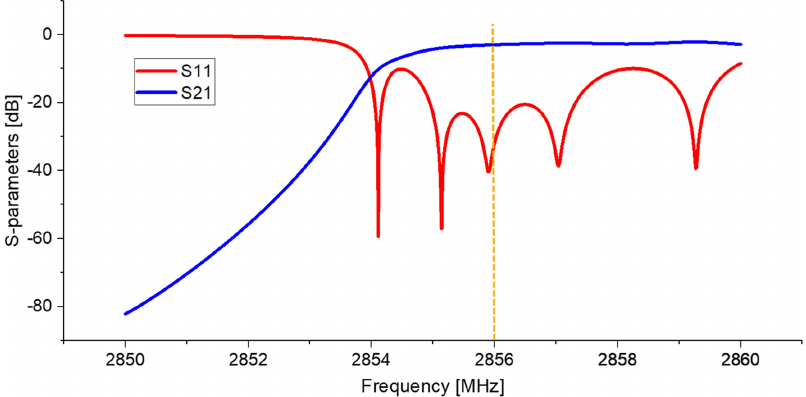
FIG. 16. Reflection (S11, red) and transmission (S21, green) characteristics of the NHS 15-cells structure with